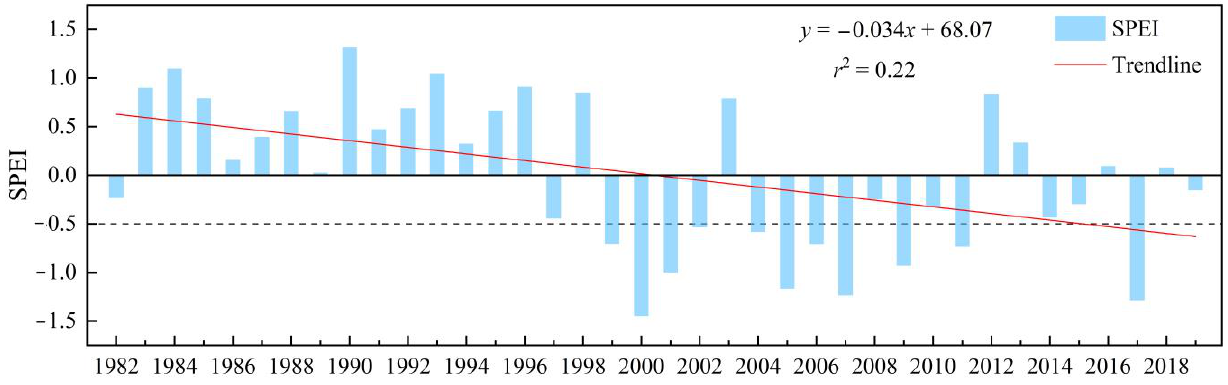
Figure 10. Change trend of SPEI over time. The blue bar chart is the long-term average value of SPEI in Inner Mongolia. The red line is the trendline. The slope of the trend line is − 0.034, p < 0.05. The black dotted line is the threshold for drought occurrence.